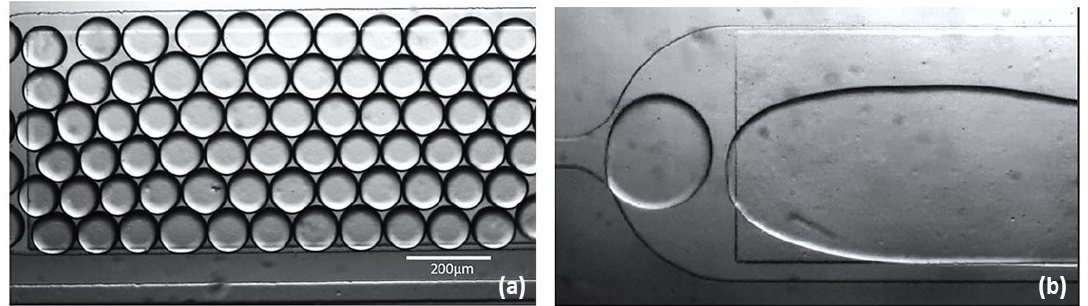
Figure 6. Surfactant KryAz600, ( a ) mono-disperse (water-in-oil) droplets of stable trans state, ( b ) effect of UV exposure, unstable cis state causing coalescence of